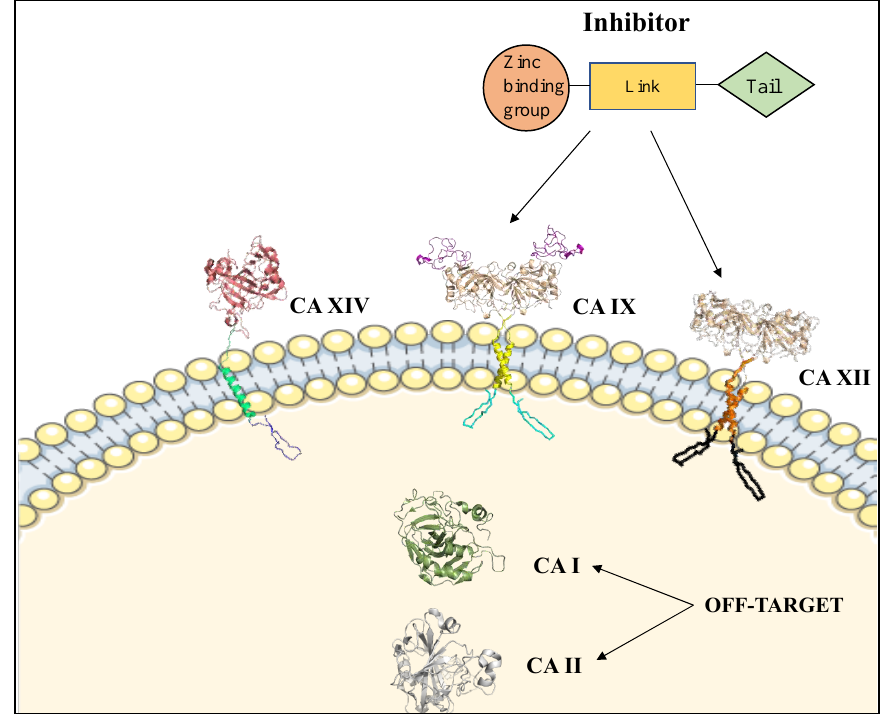
Figure 4. Schematic of membrane-bound CA IX, CA XII, and CA XIV and cytosolic, off-target CA II within the context of the cell. Insert: Structural components of CAIs: zinc binding group, linker and tail.